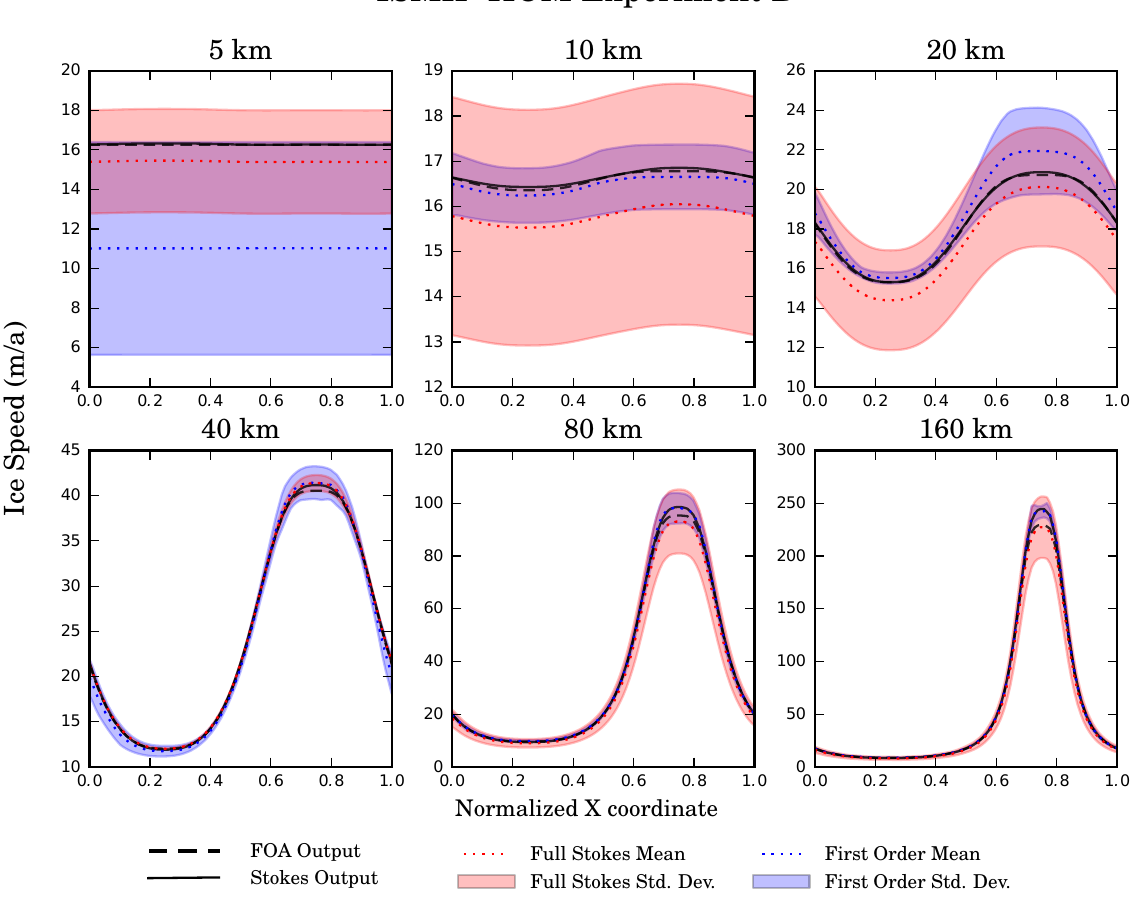
Fig. 7. ISMIP-HOM D performed using first-order and Stokes’ approximations.